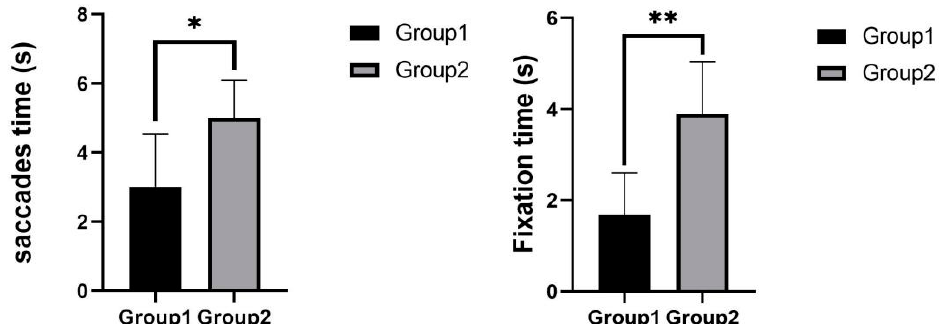
Figure 8. Saccades time and fixation time in telephone task. * indicates significant difference ( p < 0.05). ** indicates significant difference ( p < 0.01).